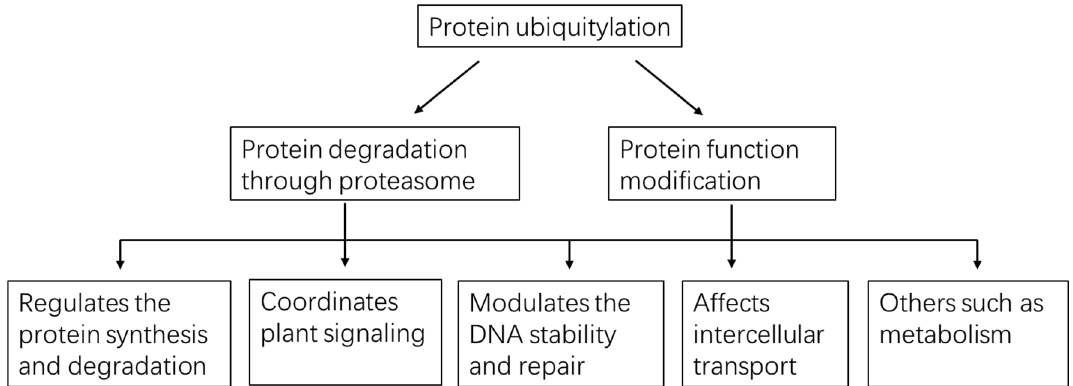
Figure 3. A global view of functions played by protein ubiquitylation in plants.